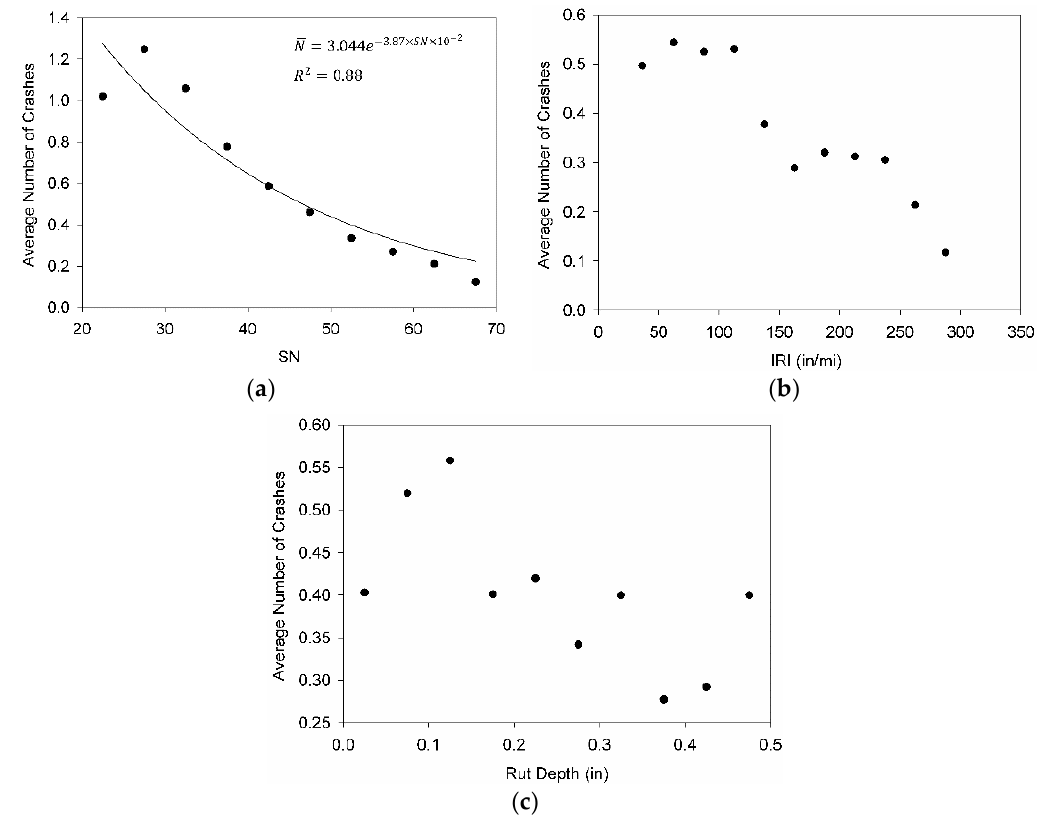
Figure 5. The empirical trends between the average number of crashes and ( a ) SN; ( b ) IRI; and ( c ) RD.